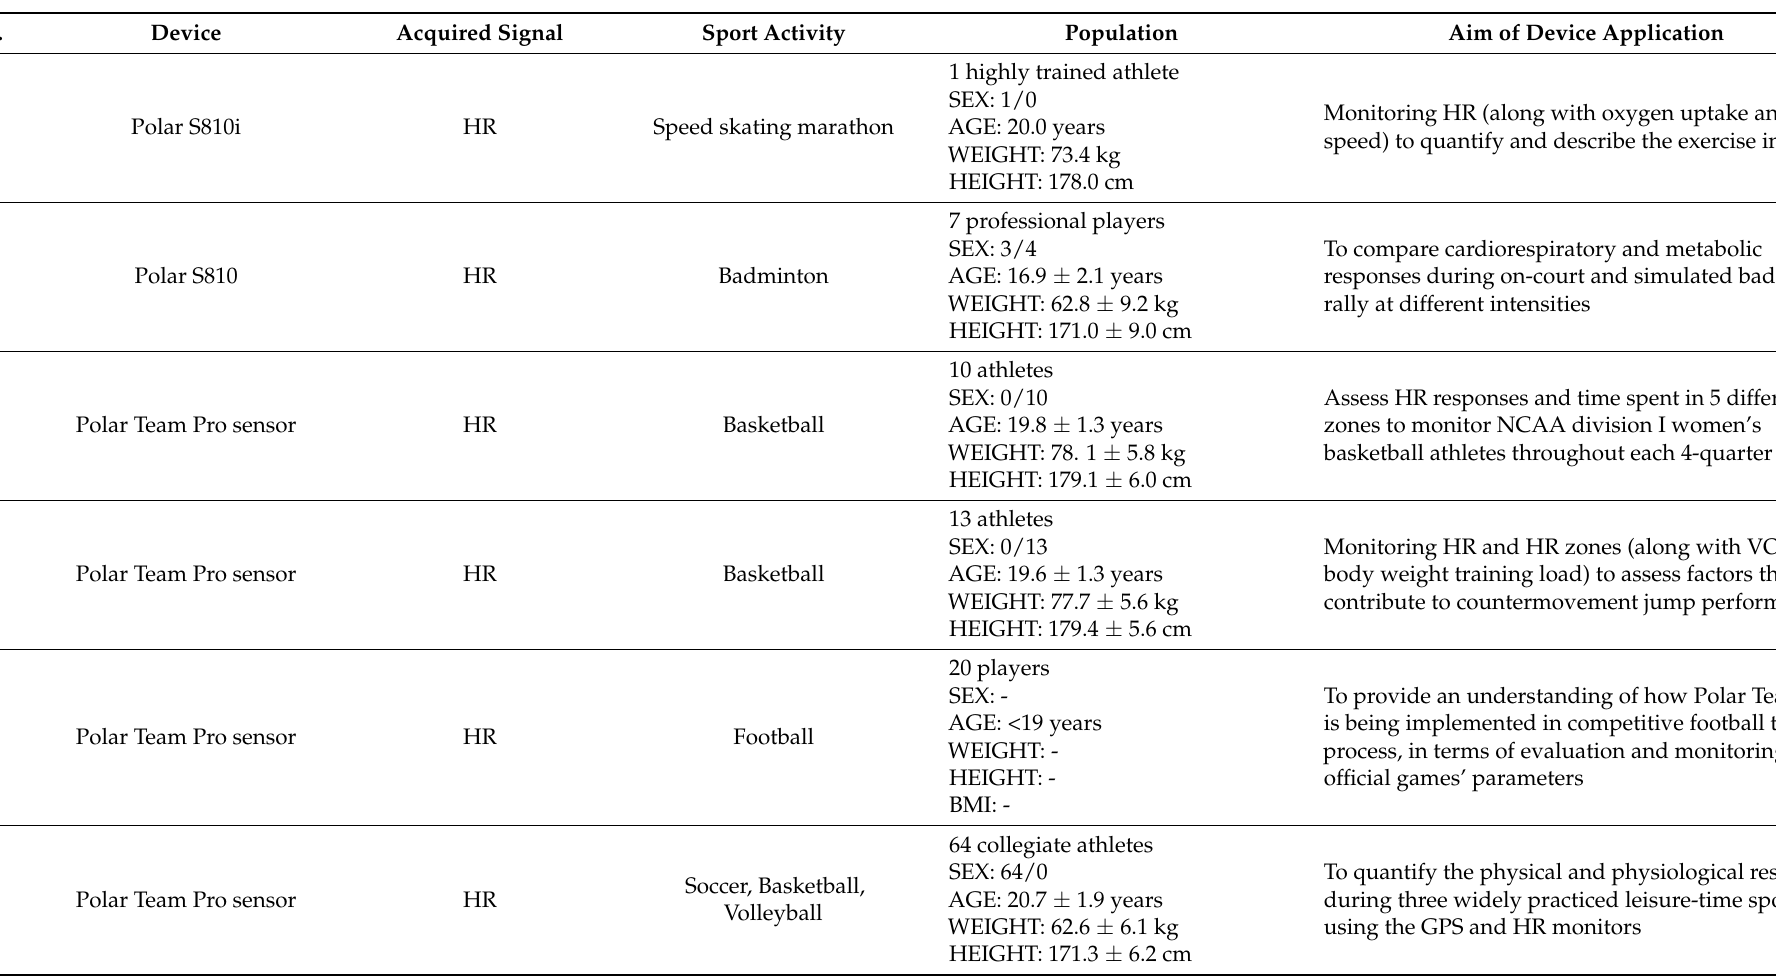
Table 2. Clinical studies characterized by the used wearable or portable device, the acquired signal (ECG and/or HR), the practiced sport activity, the population characteristics and the aim of device application. Devices are reported with their commercial name and the population characterized in terms of sex (male/female), age, and BMI. If not, present height and weight are reported. Information not available is reported as “-”.